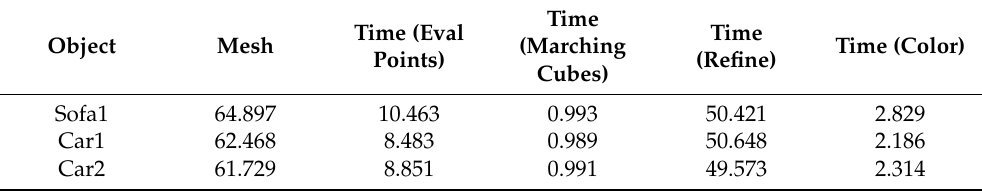
Table 5. Time for DVR to produce object 3D model (unit: